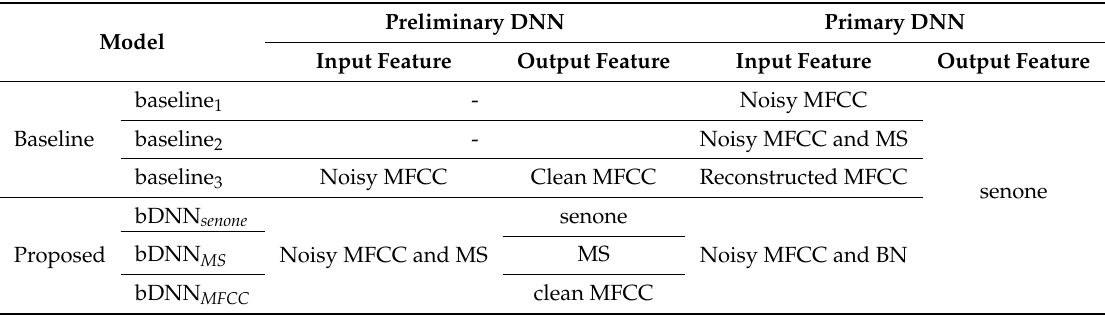
Table 2. Model specifications (the MS and BN indicate the motor-state and latent feature, respectively).